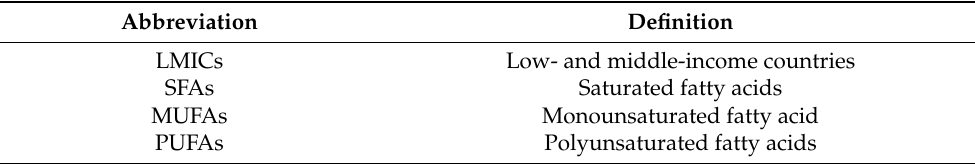
Table 1. List of abbreviations and acronyms used in the